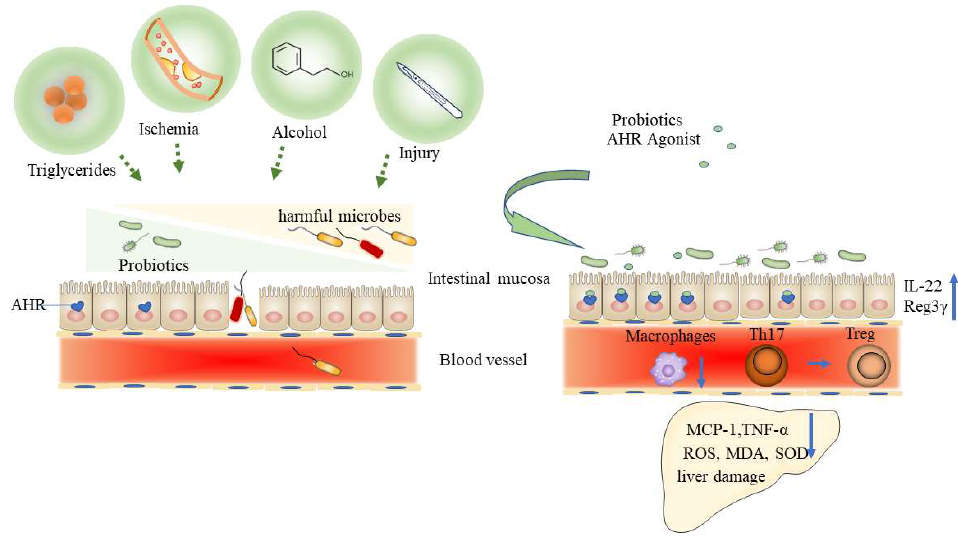
Figure 4. Gut microbiota-regulation of AHR signaling in the liver diseases. Triglycerides as in NAFLD, alcohol as in ALD, ischemia, surgical injury and other factors lead to the dysregulations of the microbiome and gut-derived metabolites, which can against the activation of the AHR, increase the intestinal permeability and incur the bacteria translocation into the blood. By providing probiotics or AHR agonists, the AHR signaling pathway was activated to reduce the intestinal permeability, decrease the immune macrophages, inhibit the transformation of Th 17 cells into Treg cells, and finally enhance the intestinal expression of IL-22 and Reg3 γ , which ultimately alleviate the liver damage via down-regulating the inflammatory factors such as MCP-1, TNF- α , ROS, MDA and SOD. Abbreviations: AHR, aryl hydrocarbon receptor; Treg, regulatory T cells; REG3γ, regenerating islet-derived protein; MCP-1, monocyte chemoattractant protein-1; TNF- α , tumor necrosis factor- α ; ROS, reactive oxygen species; MDA, malondialdehyde; SOD, superoxide dismutase.